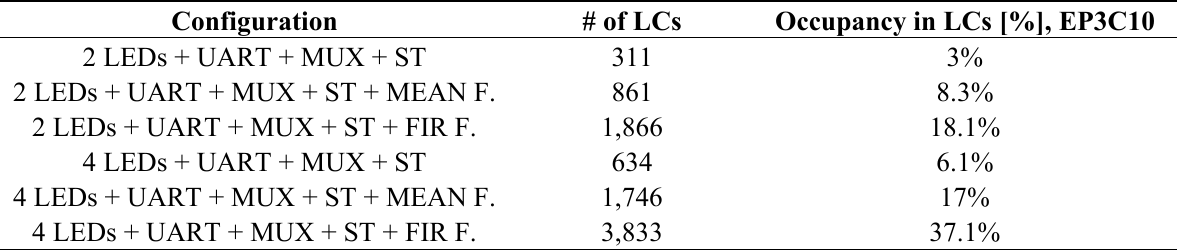
Table 1. FPGA resources for different configurations of PPG sensor, expressed in LCs.